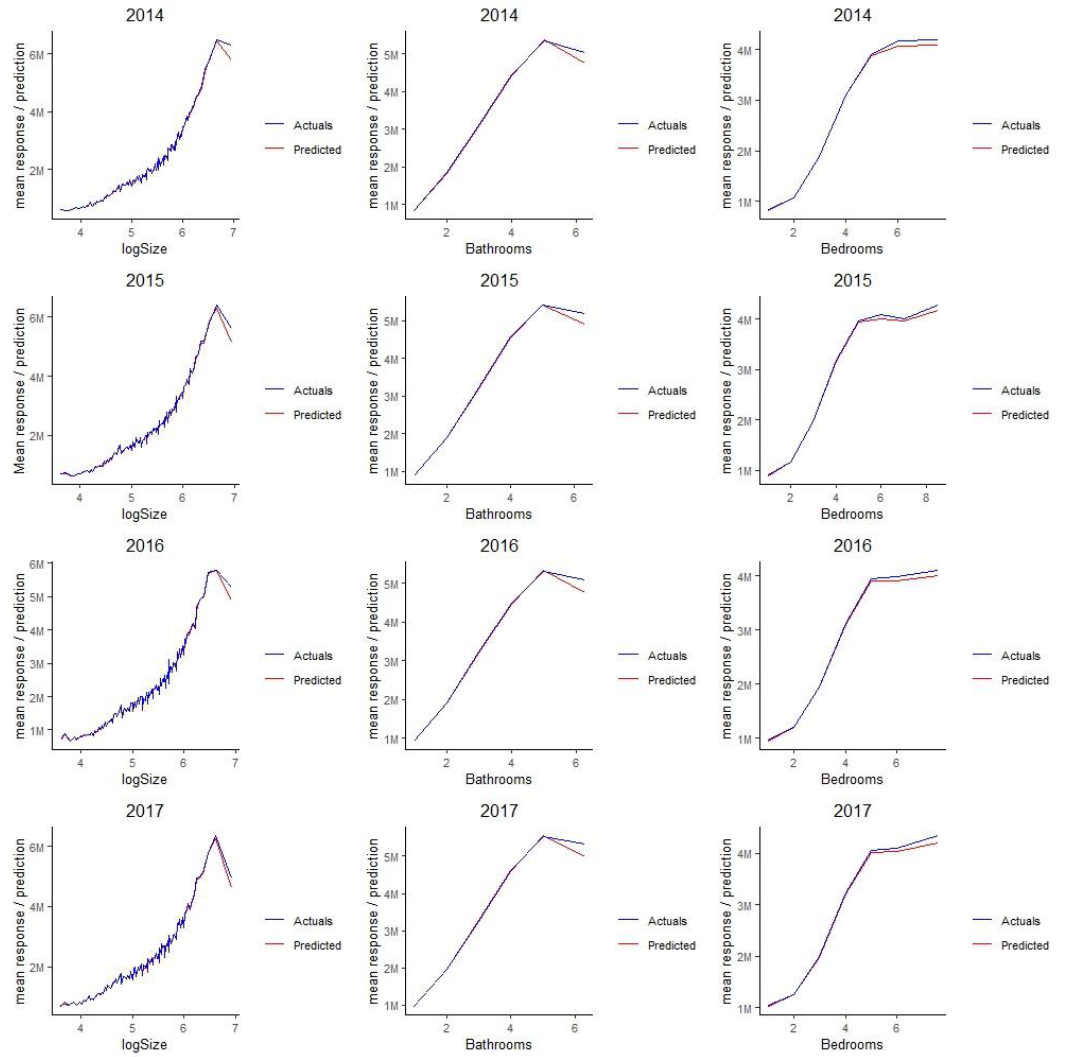
Figure 3: Partial Dependence Calibration